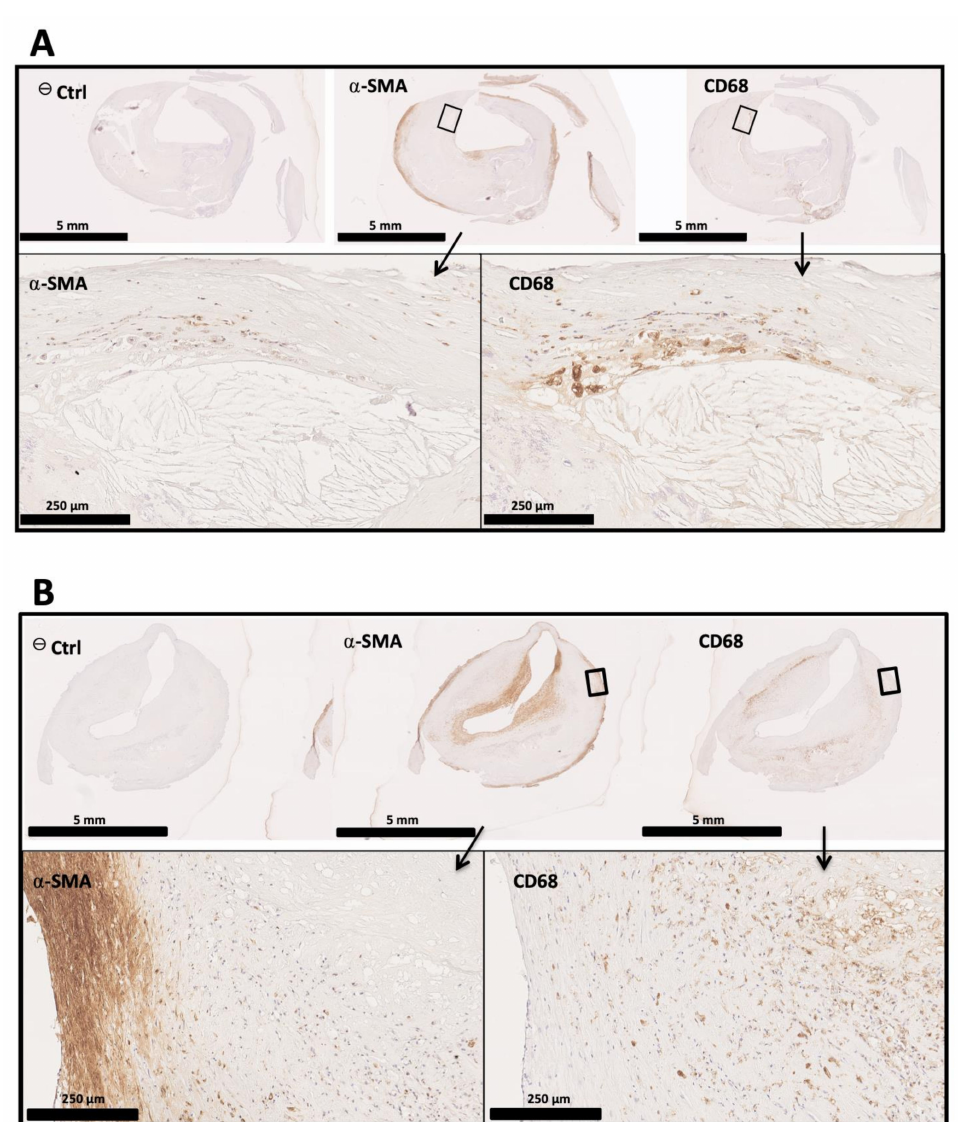
Figure 2. Immunohistological analysis of human atherosclerostic carotid samples. Human atherosclerotic carotid sections were stained for α SMA and CD68. Higher magnifications show areas positive for both staining, containing cells which seem to express both SMA and CD68, suggesting a phenotypic transition of VSMCs from contractile or synthetic towards a phagocytic subset. ( A ) Example of an advanced atherosclerotic section with an important necrotic core and a thin fibrous cap (few α SMA-positive cells). Higher magnifications of the delineated area show the interface between the fibrous cap and the underlying necrotic core containing cholesterol crystals. ( B ) Section of human atheromatous lesion with a thick fibrous cap. Higher magnifications show the interface between the media and the necrotic core, containing cells with potentially intermediate phagocytic/contractile